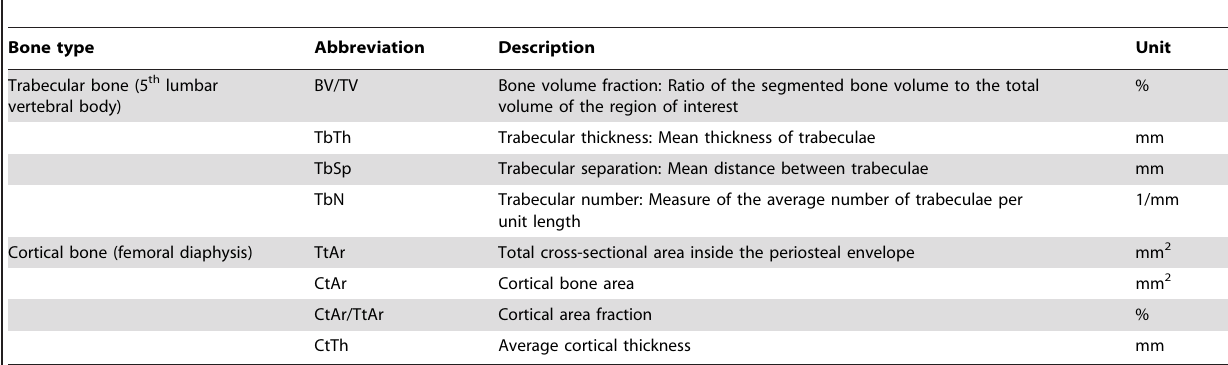
Table 1. Definition and description of parameters for trabecular bone microarchitecture and cortical bone morphology.